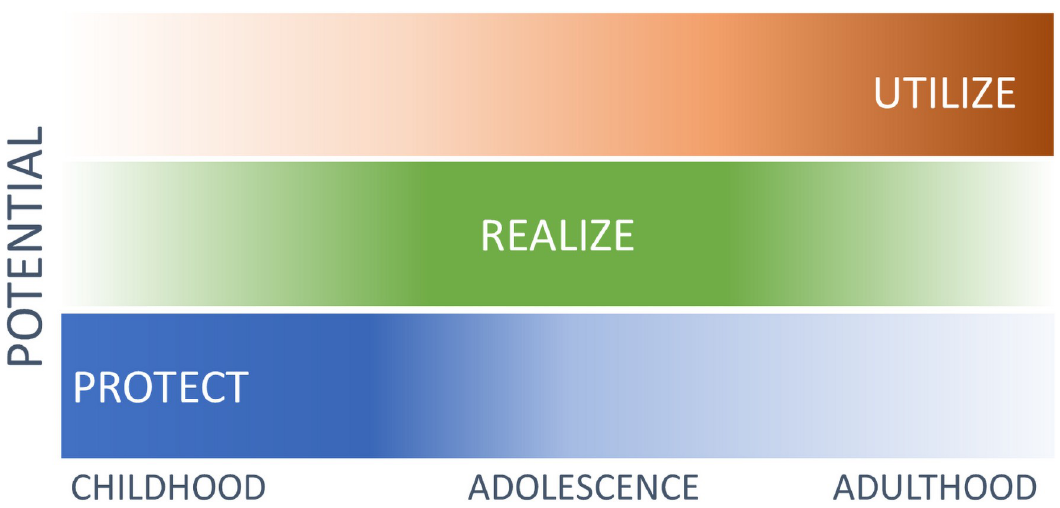
Fig 2. Human development framework. The framework focuses on human development, rather than intermediary outcomes. It includes three interacting types of influence on human development: The protection of potential; the realisation of potential; and the utilisation of potential. To be realized, potential must be protected, and to be utilized, potential must be realized. Influences which protect potential are concentrated in early life, those which lead to the realisation of potential cluster in mid-childhood and adolescence; and those which determine the possibility of utilising potential are concentrated in adulthood. While concentrated in particular periods, influences of each type can be found at every life stage. This framework is an adaptation of Nussbaum’s work on basic, internal, and combined capabilities [22]. Nussbaum focused on the interaction of individual development and the contexts in which people live, this framework deviates from Nussbaum in its treatment of biological development which she assumed was essentially automatic